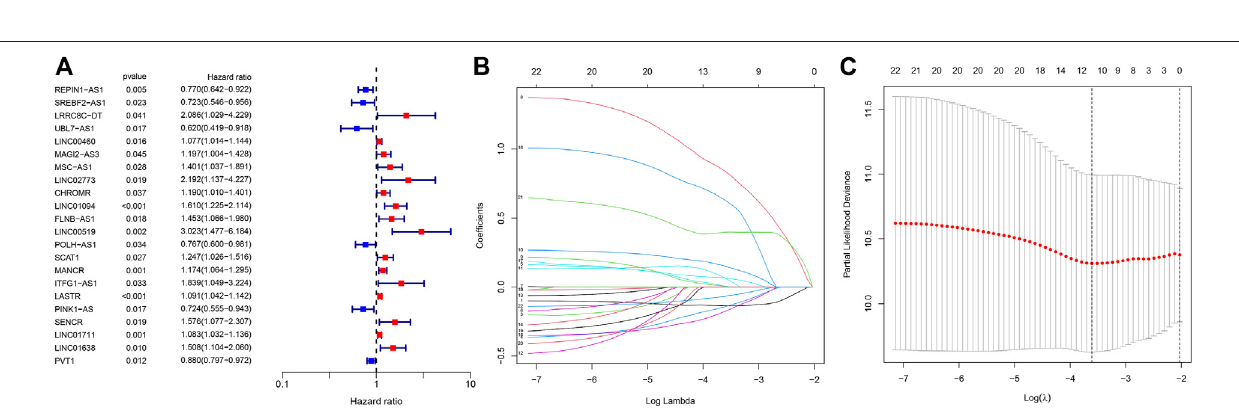
FIGURE 3 | Univariate regression analysis and LASSO regression analysis. (A) The forest plot of prognostic-related lncRNAs. (B) LASSO coef fi cient pro fi les of necroptosis-associated lncRNAs. (C) The partial likelihood deviance with changing of log( λ ). *: p < 0.05 **: p < 0.01 ***: p < 0.001.